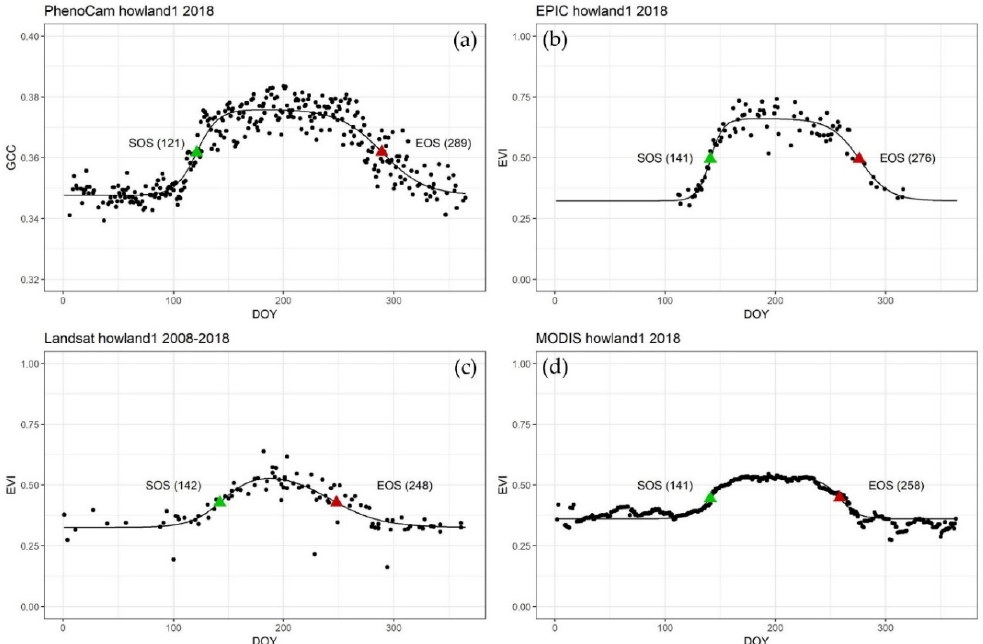
Figure A3. Derived vegetation phenology indicators of SOS and EOS from EVI for evergreen needleleaf study site ‘howland1’ based on ( a ) PhenoCam, ( b ) EPIC, ( c ) Landsat, and ( d ) MODIS observations. The green triangles indicate SOS, and the red triangles indicate EOS for each time series. The y-axis scale was kept constant for Landsat, MODIS, and EPIC, but adjusted for PhenoCam to better show the shape of the curve.